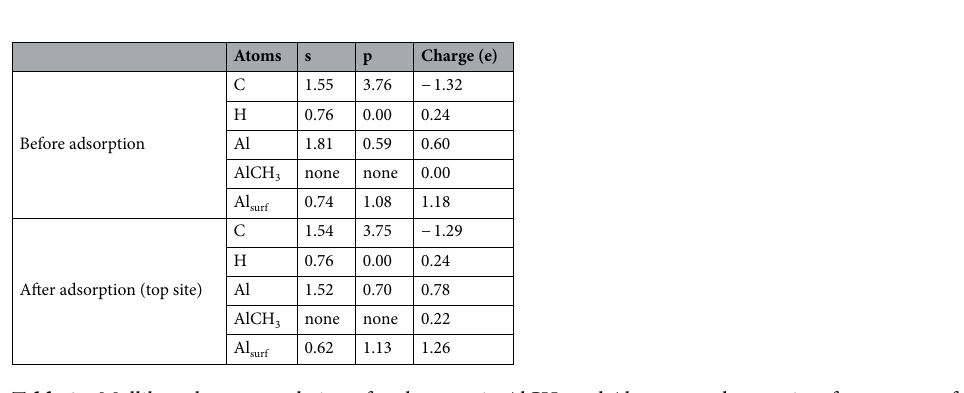
Table 2. Mulliken charge population of each atoms in AlCH 3 and Al atom on the top site of topmost surface before and after